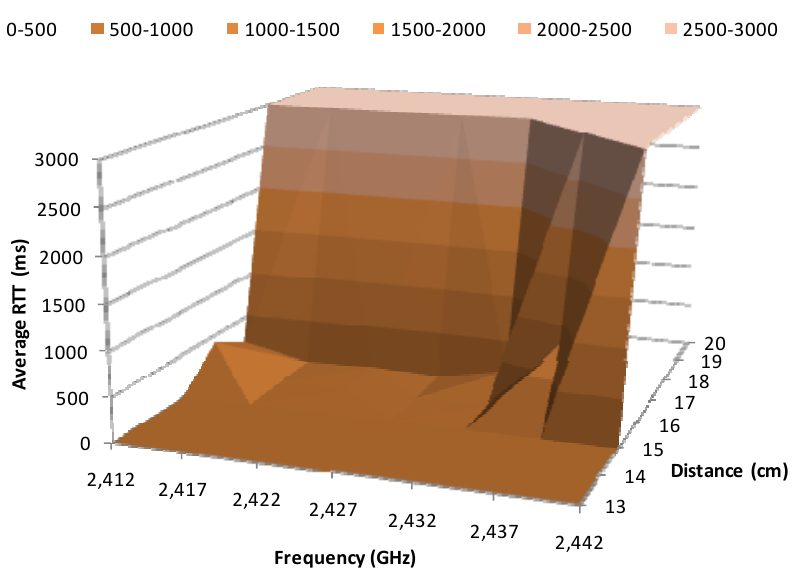
Figure 10. Average RTT for 2